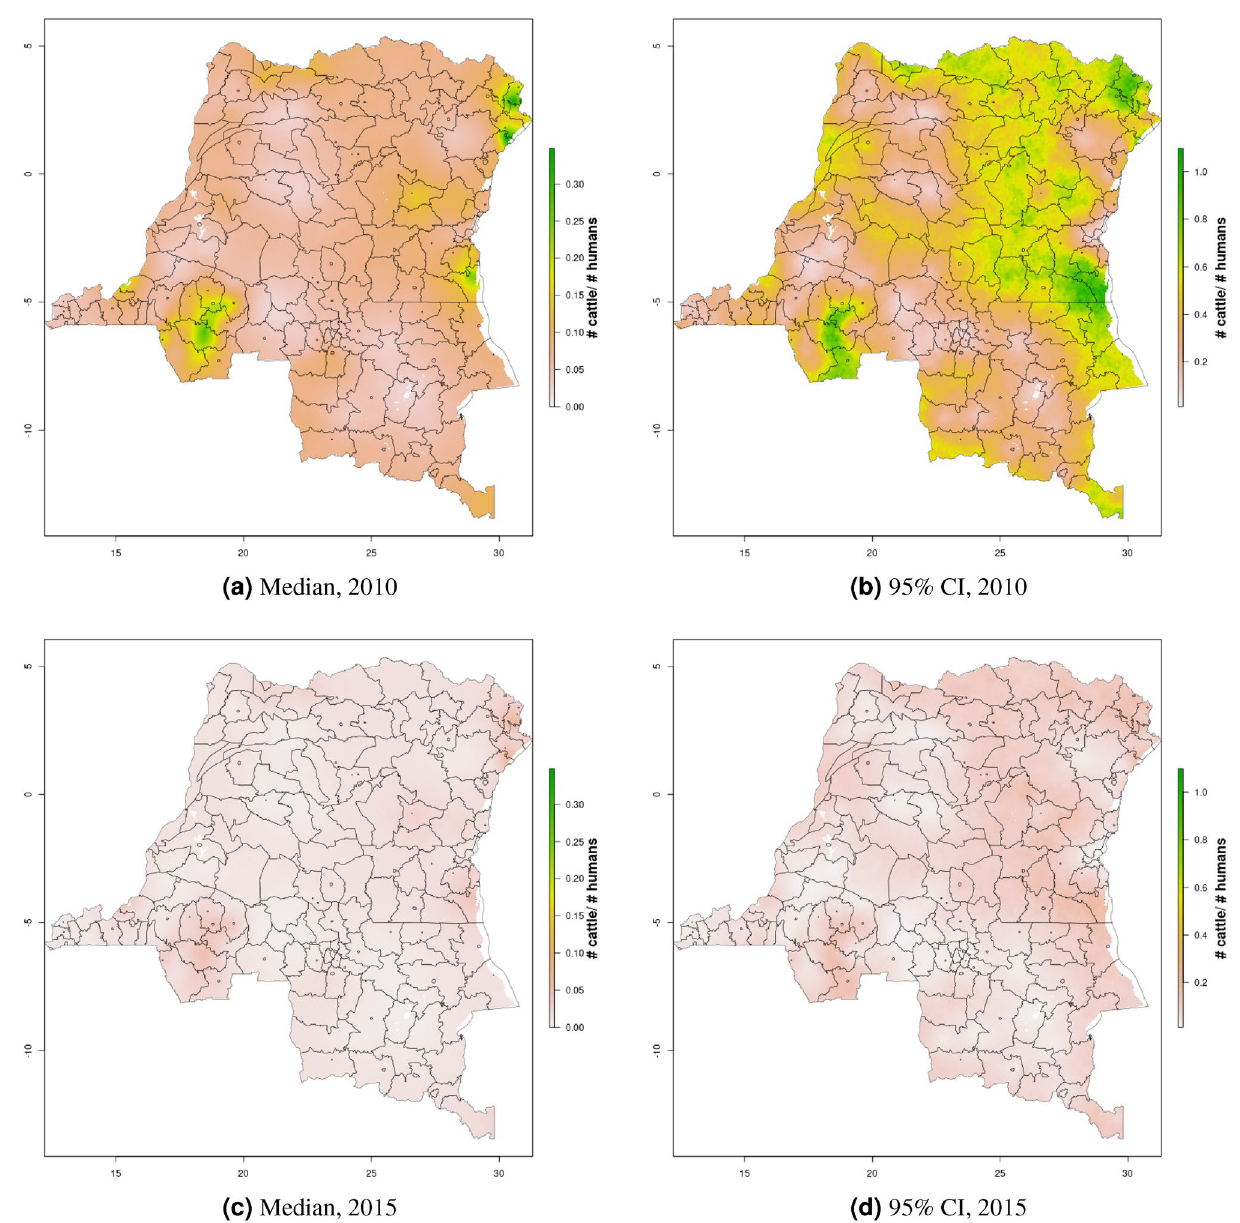
Figure 8. Cattle density mapping results, DRC, 2010 and 2015. Median ( a, c ) and width of posterior 95% credible interval ( b,d